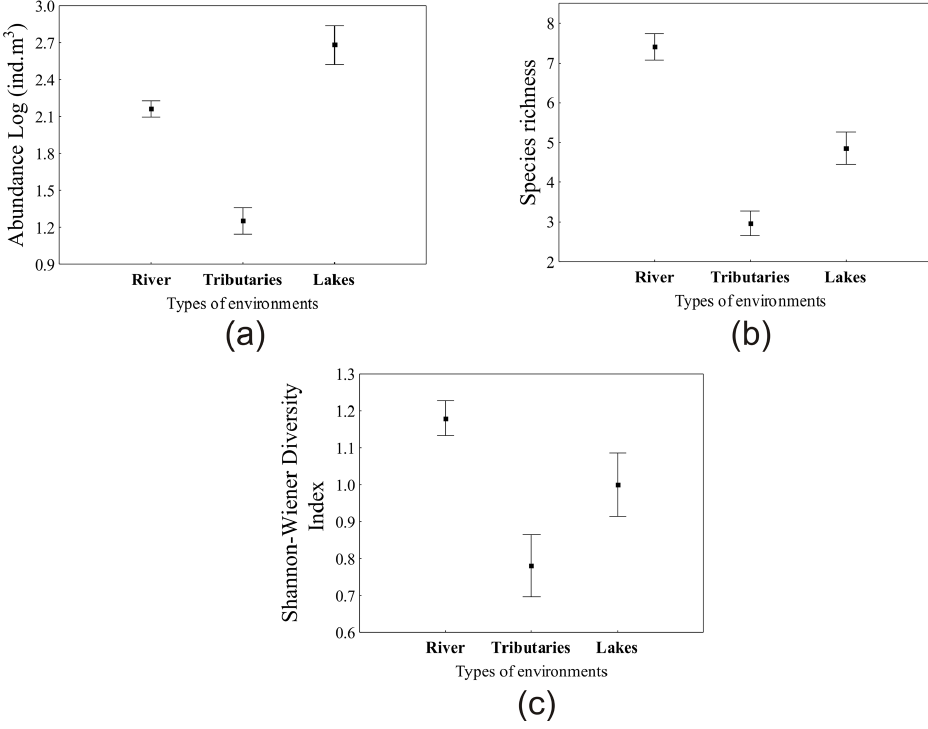
Figure 7. Copepod abundance (a), species richness (b), and diversity (c) in each type of environment sampled. Symbols represent mean values and vertical bars represent standard